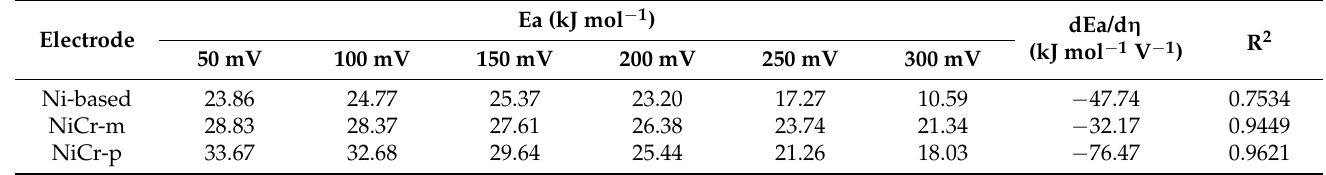
Figure 6. Arrhenius plots of the NiCr-p electrode at different overpotentials. ( a ) Ni-based, ( b ) NiCr-m, and ( c ) NiCr-p electrodes. Table 2. Apparent activation energy values at different overpotentials.